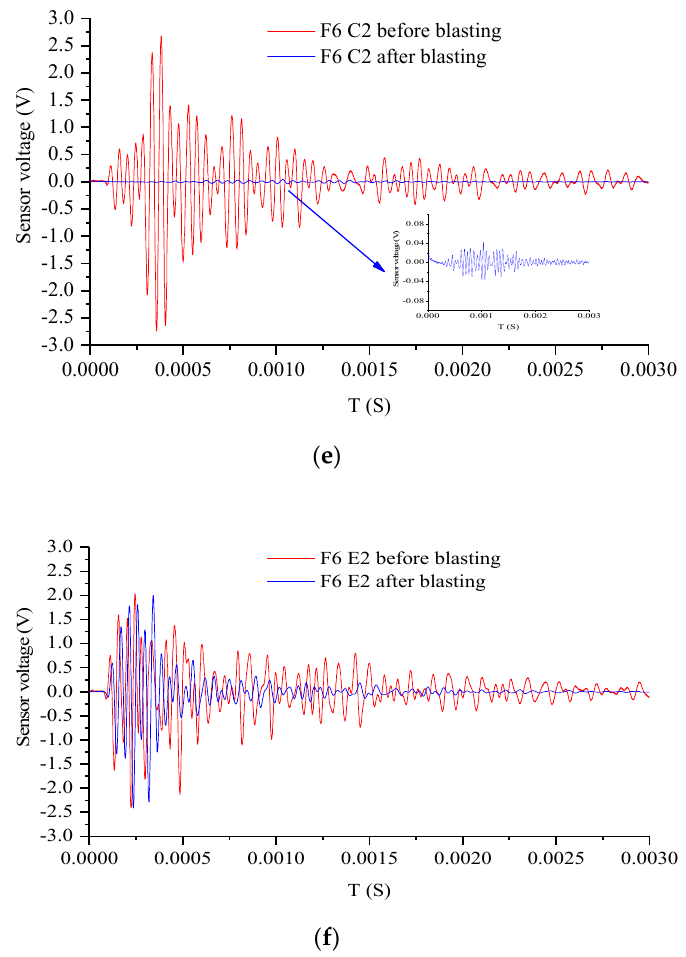
Figure 12. Waveform based on active sensing: test points ( a ) A2 of F5, ( b ) C2 of F5, ( c ) E2 of F5, ( d ) A2 of F6, ( e ) C2 of F6, and ( f ) E2 of F6.